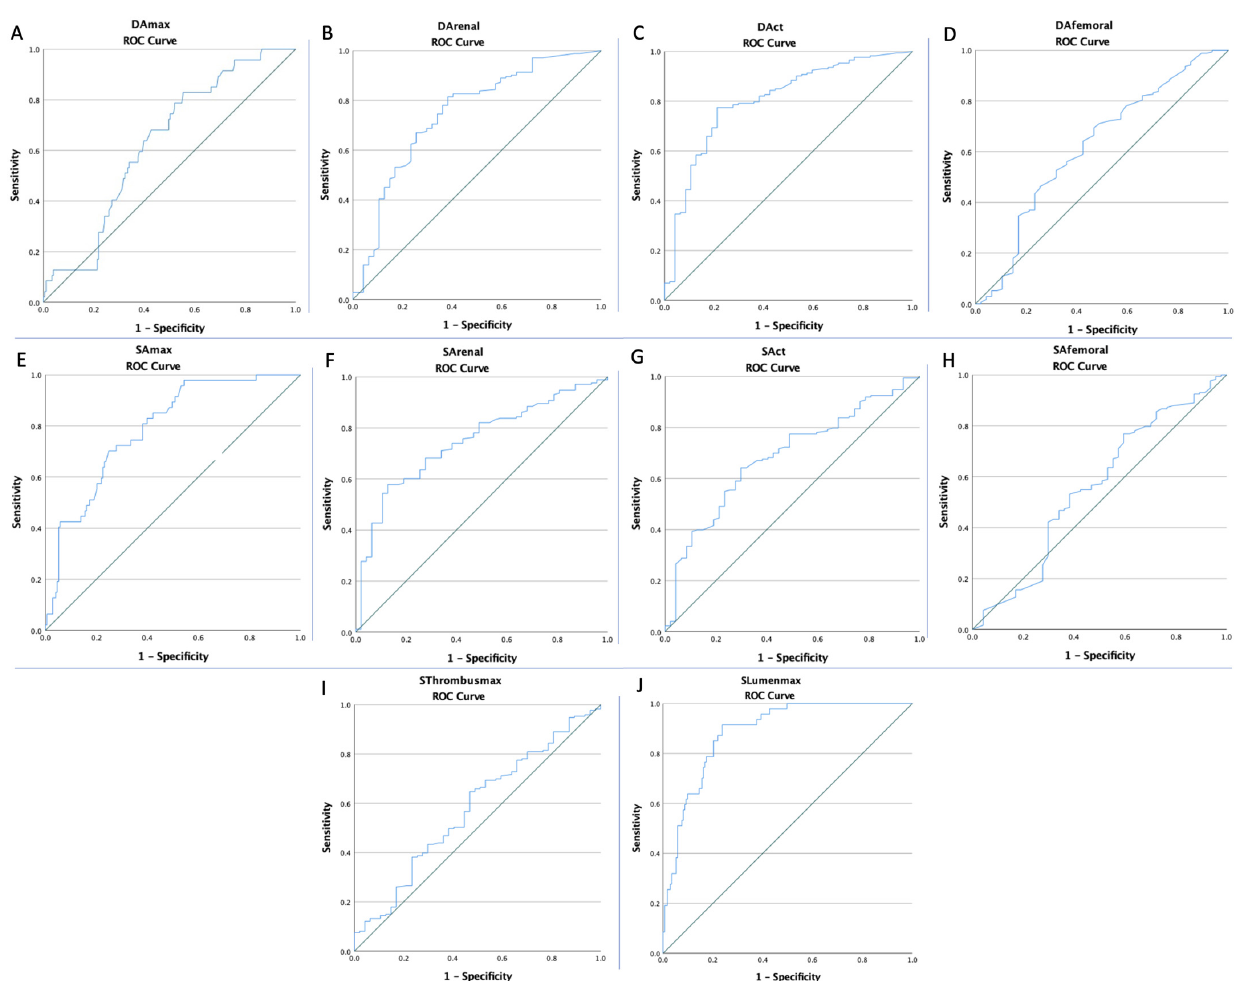
Figure 2. The ROC curve analysis concerning AAA rupture for the ( A ) DA max (AUC: 0.630; p = 0.006), ( B ) DA renal (AUC: 0.744; p < 0.0001), ( C ) DA CT (AUC: 0.802; p < 0.0001), ( D ) DA femoral (AUC: 0.620; p = 0.01), ( E ) SA max (AUC: 0.789; p < 0.0001), ( F ) SA renal (AUC: 0.746; p < 0.0001), ( G ) SA CT (AUC: 0.684; p < 0.0001), ( H ) SA femoral (AUC: 0.556; p = 0.24), ( I ) SLumen max (AUC: 0.887; p < 0.0001), and ( J ) SThrombus max (AUC: 0.577; p = 0.10).